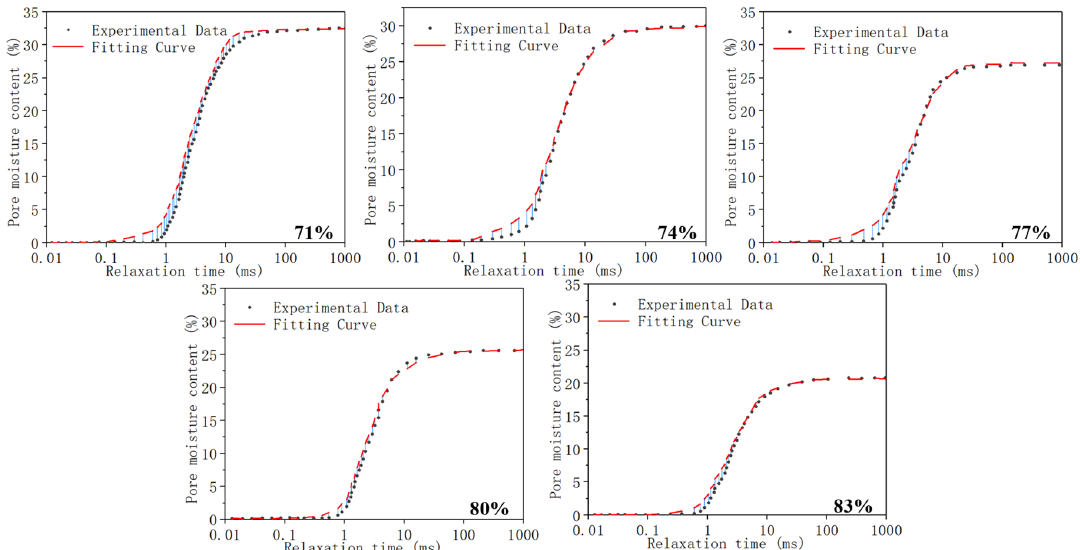
Figure 11. Regression analysis of the water retention model of backfill with the cement–tailings ratio of